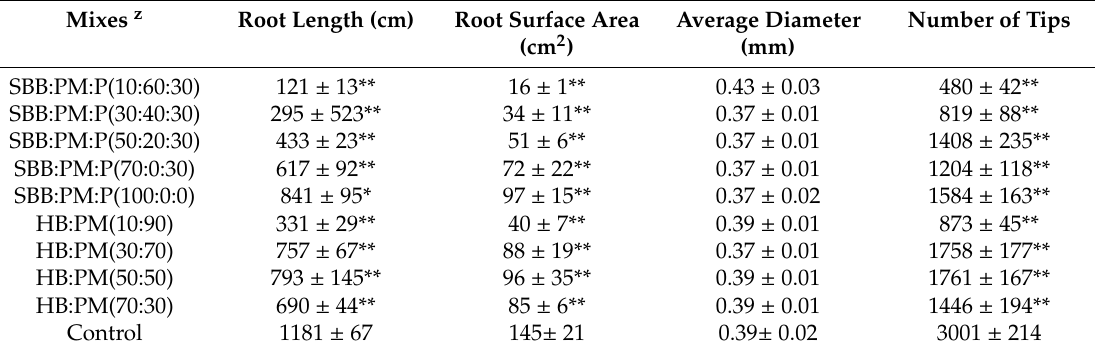
Table 3. Root growth of basil seedlings grown in di ff erent mixes (*, ** indicate a significant di ff erence from the control using Dunnett’s test at p ≤ 0.05 and p ≤ 0.01, respectively). Mixes